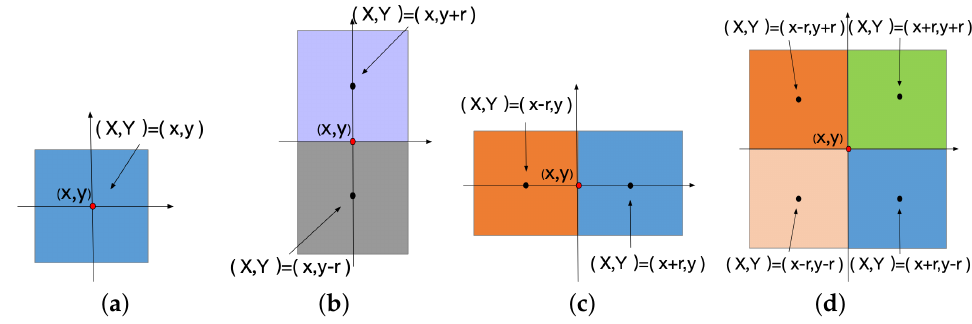
Figure 3. Let W t ( t = 1,2, . . . ,9 ) be one of the windows, and the figure shows a total of nine windows. Different black centre pixels ( X , Y ) are calculated based on the red target pixels, and then the window is determined by the centre pixels. The range of the window is horizontal reverse X − r to X + r , vertical direction Y − r to Y + r . ( a ) The target pixel is in the center of the window; ( b ) The target pixels are in the lower middle and upper middle of the window; ( c ) The target pixels are in the right middle and left middle of the window; ( d ) The target pixels are in the lower right corner, lower left corner, upper right corner, and upper left corner of the window